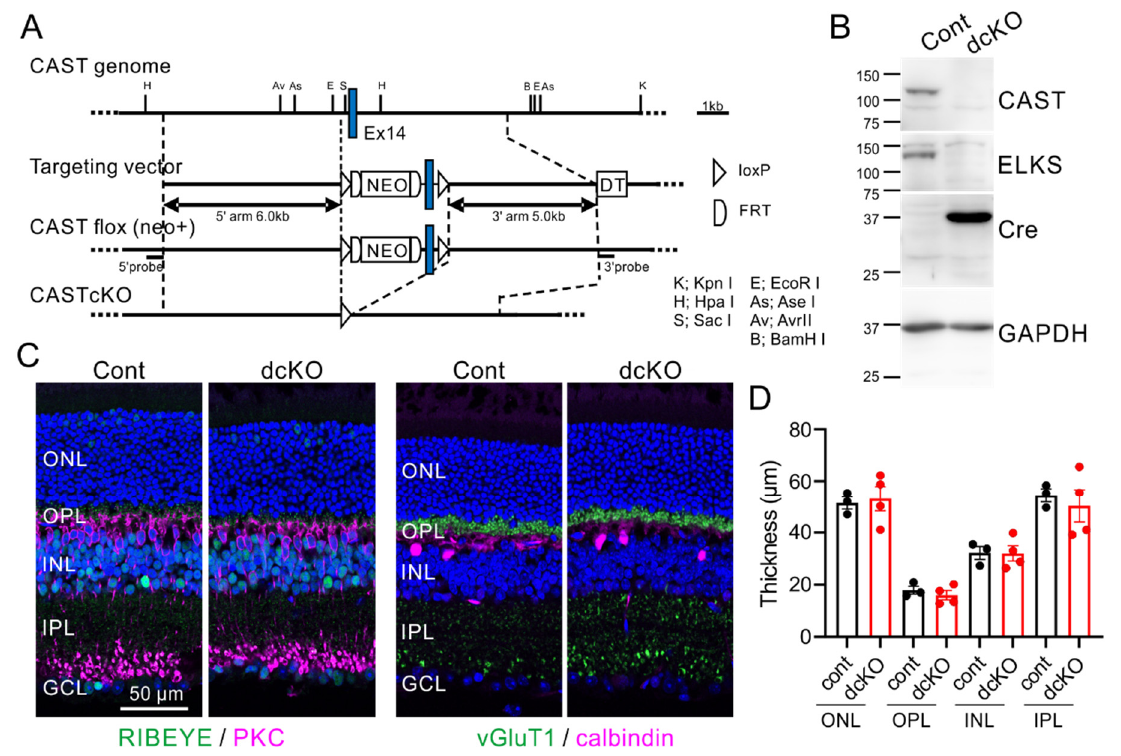
Figure 2. Specific depletion of CAST and ELKS from retina has limited impact on neural and synaptic distributions. ( A ) The CAST-flox allele contains two loxP sequences flanking exon 14 of mouse CAST. Conditional ablation of CAST was achieved by crossing flox mice with Cre-expressing lines. ( B ) Western blotting of adult retinal homogenates from control (CAST/ELKS double-floxed mouse (Cont)) and deletion mutant (CAST/ELKS double-floxed with Crx-Cre +/ − [double cKO]) mice with the indicated antibodies showed ablation of CAST and ELKS in the Cre-expressing retina. ( C , D ) Representative images of immunolabeled retinal sections showing photoreceptor ribbon synapses (anti-RIBEYE) and their terminals (anti-vGluT1) distributed in the OPL. Postsynaptic target neurons of the photoreceptor ribbon synapse (bipolar cells and horizontal cells) were immunolabeled with anti-PKC antibody and anti-calbindin antibody, respectively. The thickness of each layer was not significantly different between control and CAST/ELKS Crx-Cre double cKO mice. Mean ± SEM; ONL: outer nuclear layer; OPL: outer plexiform layer; INL: inner nuclear layer; IPL: inner plexiform layer; GCL: ganglion cell layer.